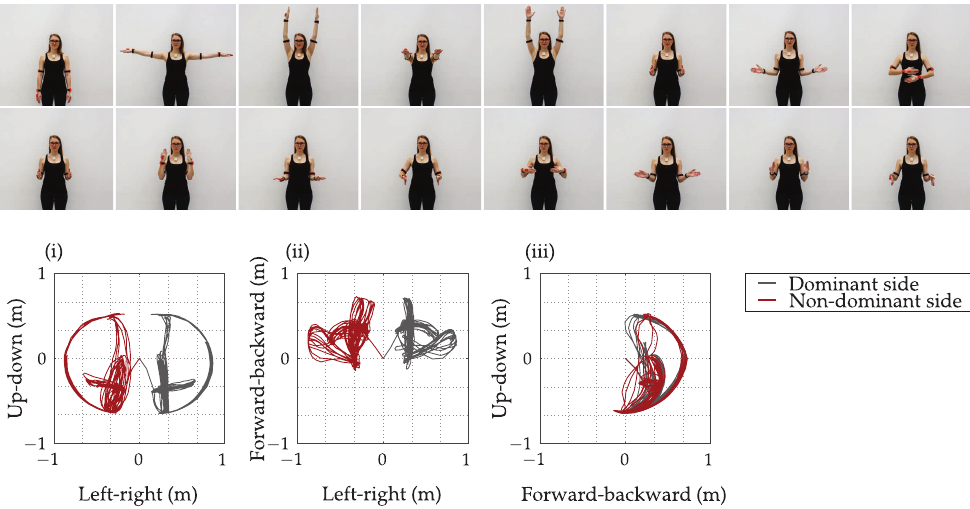
Figure 5. Symmetrical upper limb movement demonstration of a healthy subject with the correspond- ing trajectories of the arm in the frontal ( i ), transversal ( ii ) and sagittal ( iii ) plane. Black line represents the position of the dominant hand and red line represents the position of the non-dominant